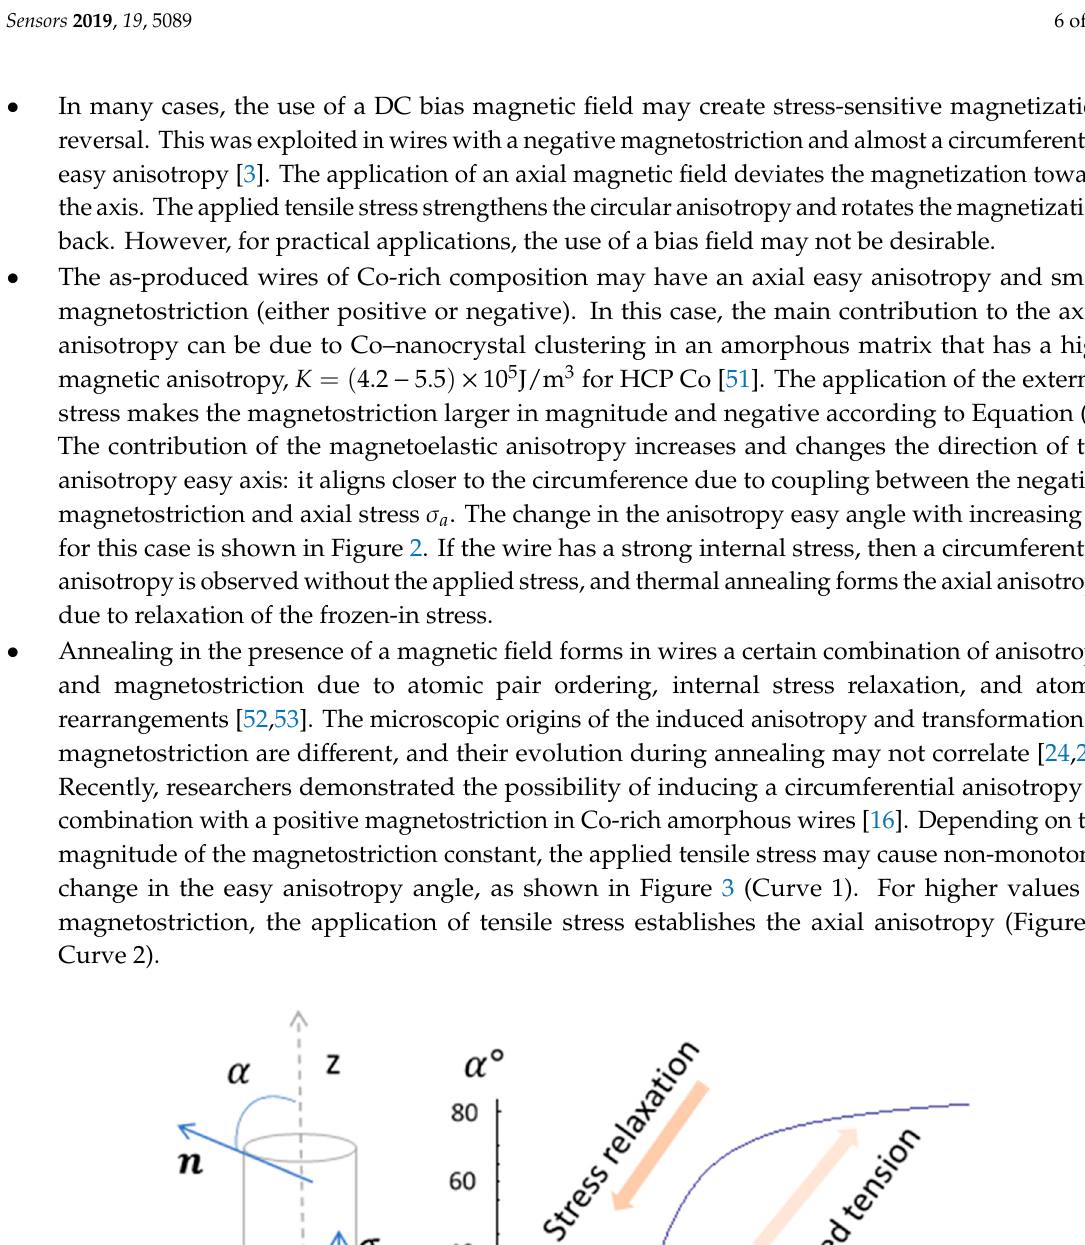
− 1 = 160 A/m. , and 2 K = M s (cid:3014) (cid:3294)